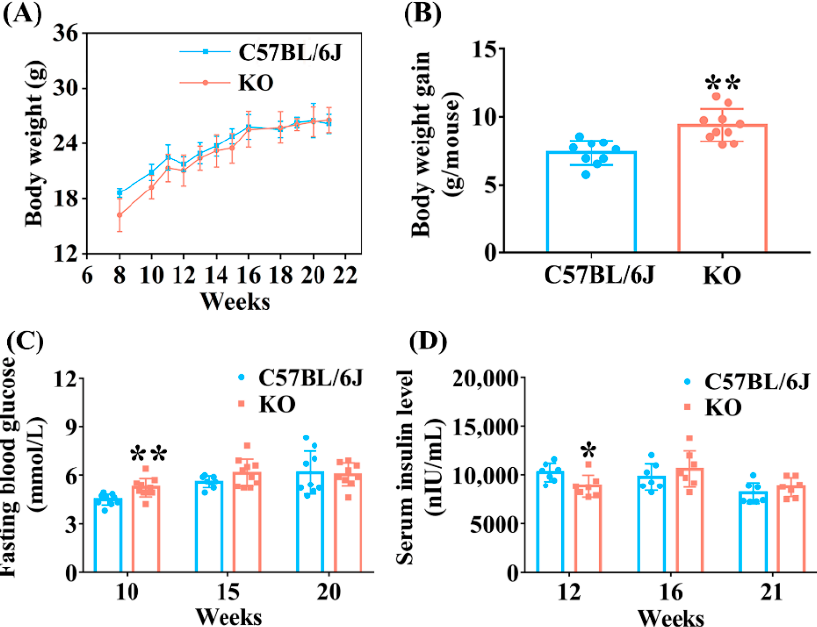
Figure 1. Metabolic phenotype analysis of selenoprotein F (SELENOF) knockout (KO) mice. ( A ) Body weight ( n = 10). ( B ) Body weight gain of mice aged 8 to 16 weeks ( n = 9 for C57BL/6J mice and n = 10 for KO mice). ( C ) Fasting blood glucose level ( n = 10 at week 10, n = 8 for C57BL/6J mice and n = 10 for KO mice at week 15, n = 9 at week 20). ( D ) Serum insulin level ( n = 7). Data were expressed as mean ± SD. * p < 0.05, ** p < 0.01, compared with C57BL/6J mice.